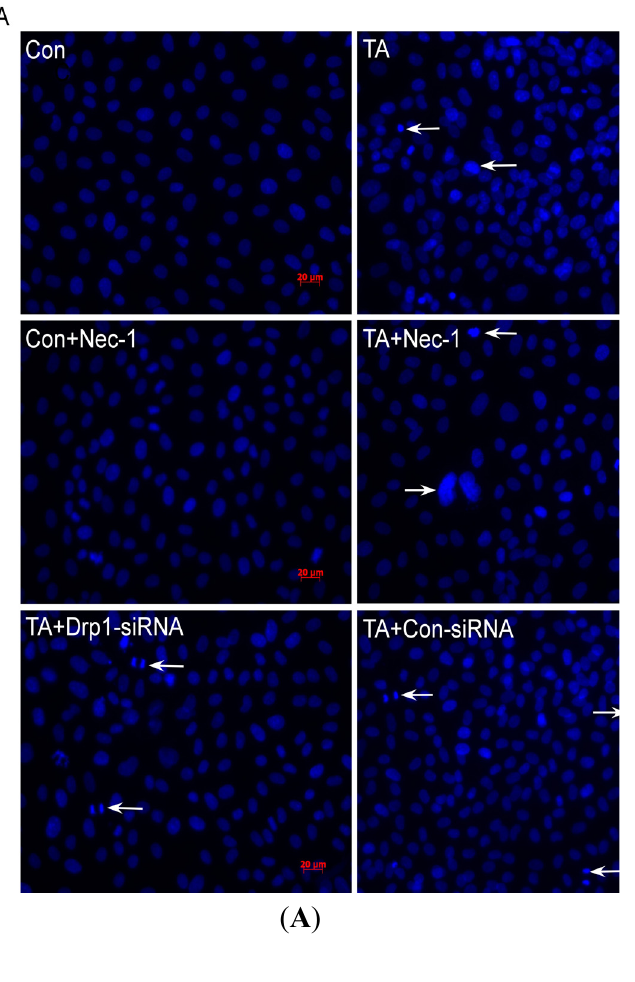
of cell deaths was observed using flow cytometry between the control group and the TA group, 4.77% ± 1.48% and 22.33% ± 4.24%, respectively ( p < 0.01) (Figure 2). The Nec-1 pretreatment protects cells from cell death caused by ischemia injury. The Nec-1+TA group showed 10.34% ± 1.55% cell death, while the TA group showed 22.33% ± 4.24% ( p < 0.05) (Figure 2). The use of inhibitor Nec-1 (20 μ M) alone had no effect on cell death (4.77% ± 1.48% and 6.11% ± 1.10%, respectively) ( p > 0.05). Figure 1. Nec-1 protected against simulated ischemia-induced cell death measured by Hoechst 33258 staining. ( A ) NRK-52E cells were exposed to simulated ischemia injury of NRK-52E cells with TNF- α stimulation and ATP depletion. After that, NRK-52E cells were incubated with Nec-1 (20 μ M) or Drp1 -siRNA (50 nM). Then, cells were stained with Hoechst 33258 (blue) Images were obtained with a fluorescent microscope. All the nuclei are uniformly weak-stained in the control group. White arrows indicate the nuclei of cell deaths (bright blue). Original magnification: ×200; ( B ) Quantification of Hoechst positive cells (%) in NRK-52e cells treated with different treatments. Data were counted from 200 cells per field and twenty fields were analyzed in each group. Note: * p < 0.01, vs. Con group; # p < 0.01, vs. TA